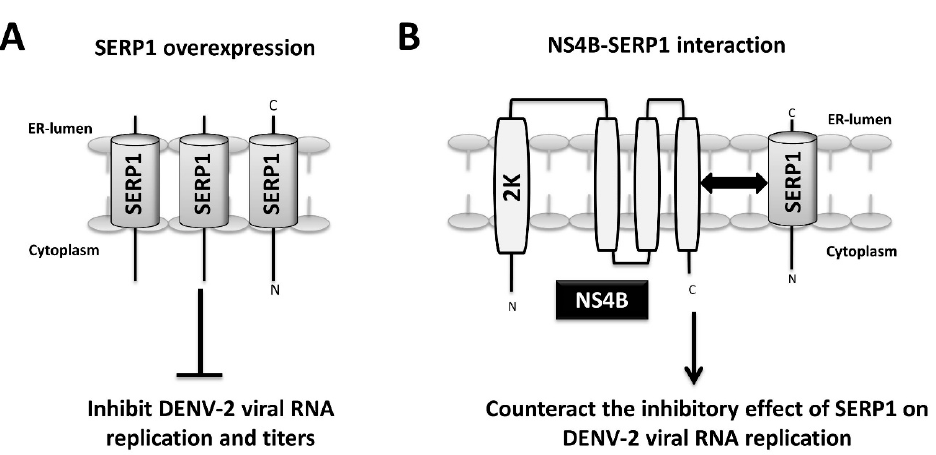
Figure 7. Hypothetical model of SERP1-mediated DENV-2 infection. ( A ) SERP1 overexpression inhibits DENV-2 viral RNA replication and titers. ( B ) DENV-2 NS4B interacts with SERP1. DENV-2 NS4B may alleviate the inhibitory effect of SERP1 on DENV-2 viral replication via the interaction of NS4B with SERP1.